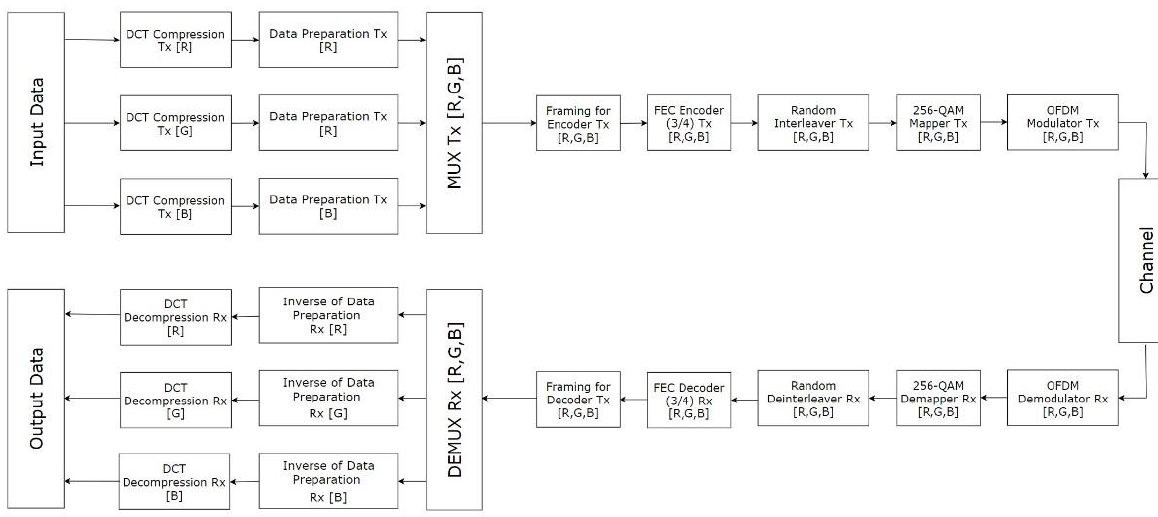
Figure 7. Simulated video transmission system. The principal parameters of the simulated system are described in Table 1.